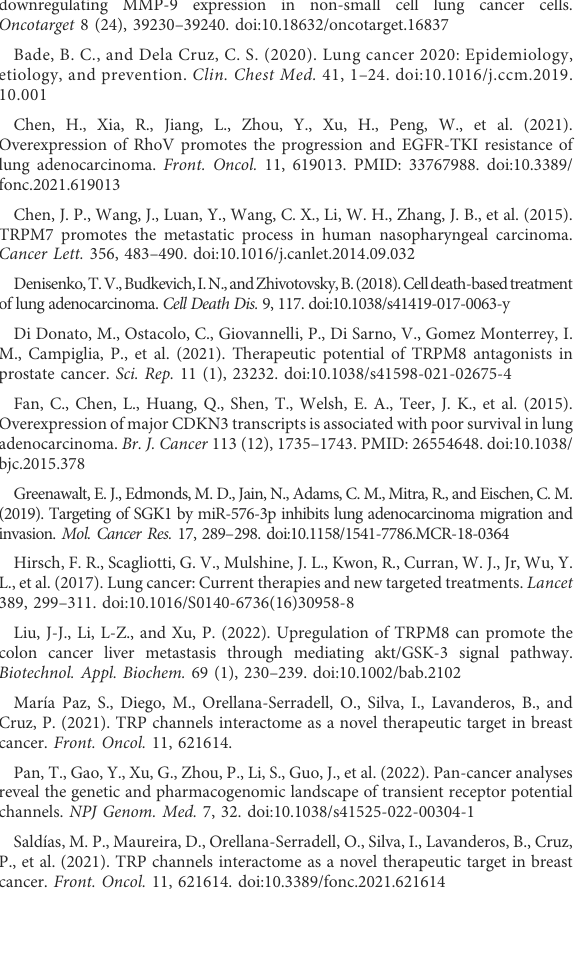
SUPPLEMENTARY TABLE S1 Chi-square test results of clinical characteristics in tumor group and control group. SUPPLEMENTARY TABLE S2 Chi-square test results of the top 20 genes with the highest mutation frequency in the high-low risk group. SUPPLEMENTARY TABLE S3 Chi-squaretestresultsofchromosomeampli fi cationanddeletioninhigh and low-risk